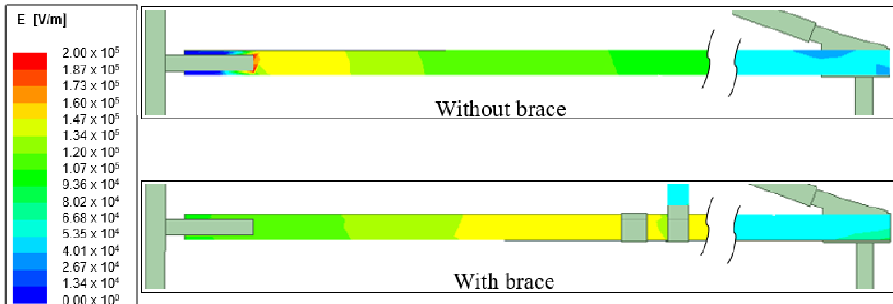
Figure 15. Changes of the E-Field profile and magnitude along B–B’ due to brace installation. Energies 2020 , 13 , x FOR PEER REVIEW